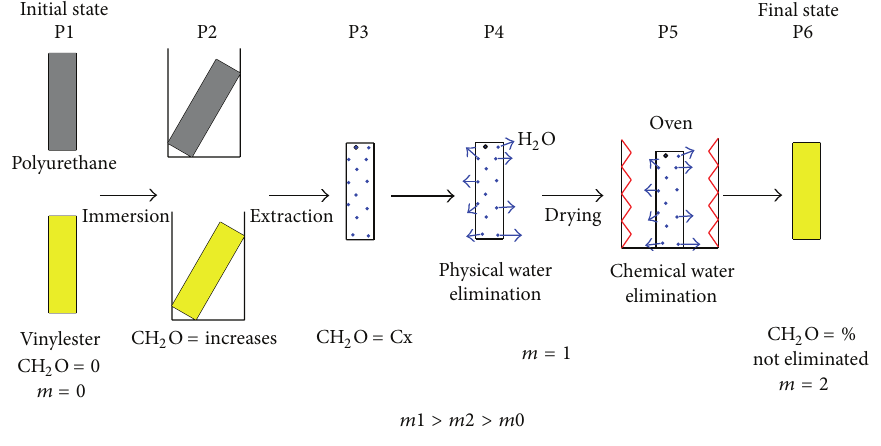
Figure 1: Degradation process.